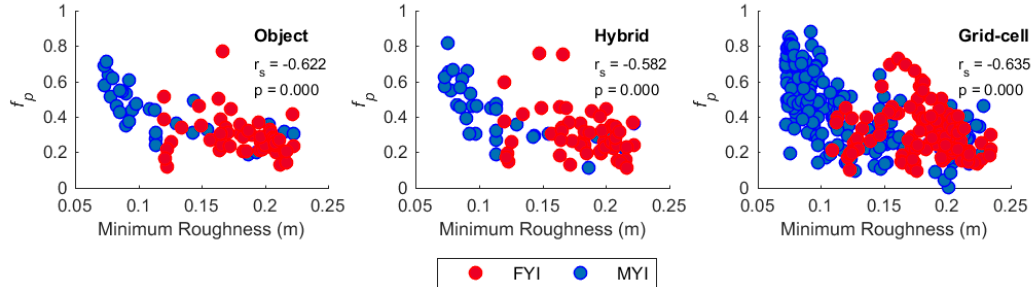
Figure 11. Scatter plots of f p as a function of smoothed minimum surface roughness at the medium scale using object ( left ), hybrid object ( middle ) and 240 m grid-cell ( right ) aggregation approaches. Spearman correlation coefficients (r s ) and corresponding p -values are shown for pooled FYI and MYI data.